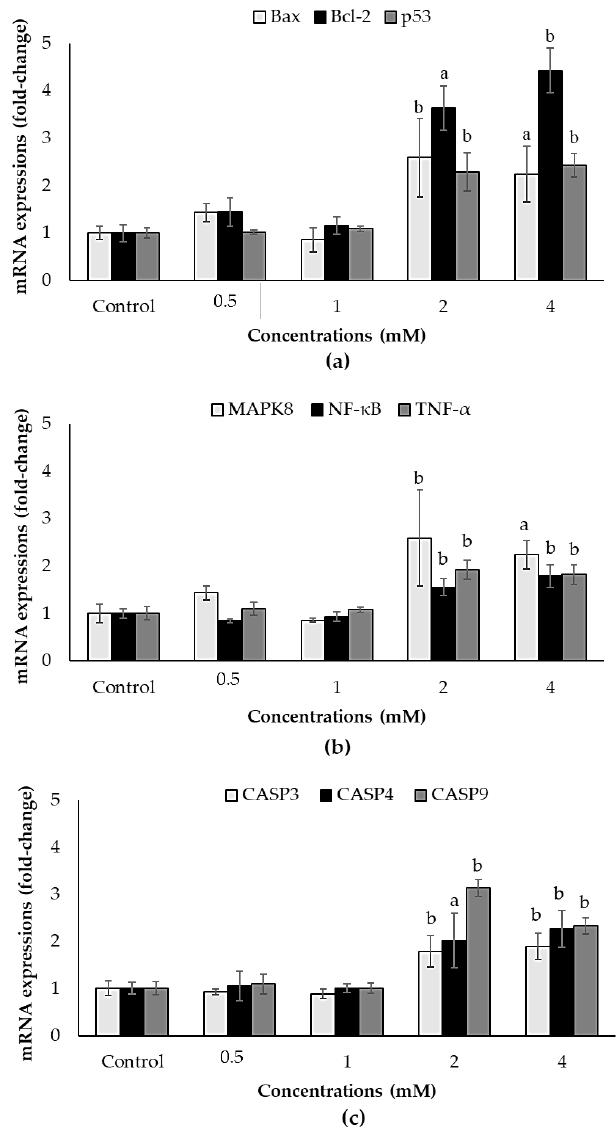
Figure 6. Effects of ACE on relative mRNA expression levels of ( a ) Bax, Bcl-2 and p53 , ( b ) MAPK8, NF-κB and TNF-α , ( c ) CASP3, CASP4 and CASP9 in SH-SY5Y cells after 24 h exposure. Data are presented as mean ± SD; and statistically significant changes are indicated as a: p < 0.05 and b: p < 0.01.